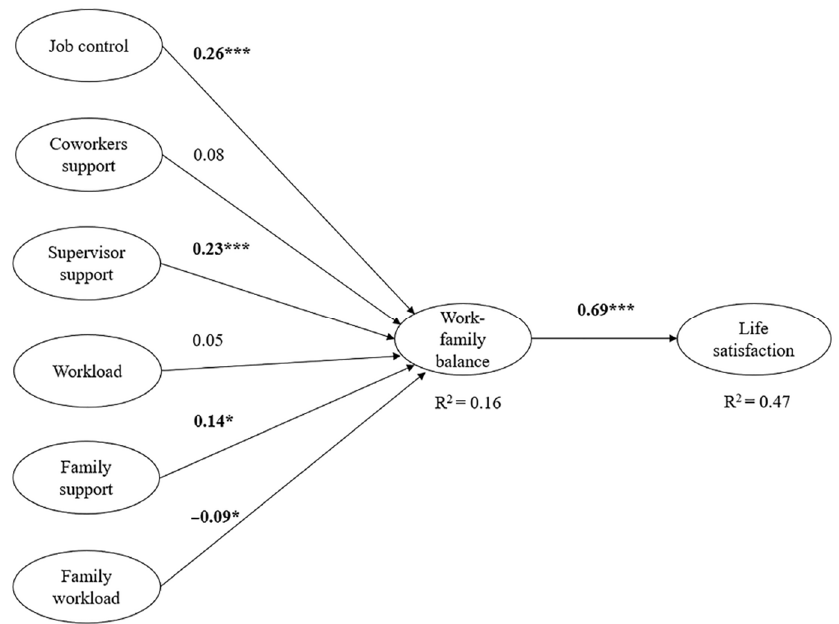
Figure 1. Structural model (standardized coefficients). Note: * p < 0.05; ** p < 0.01; and *** p < 0.001.